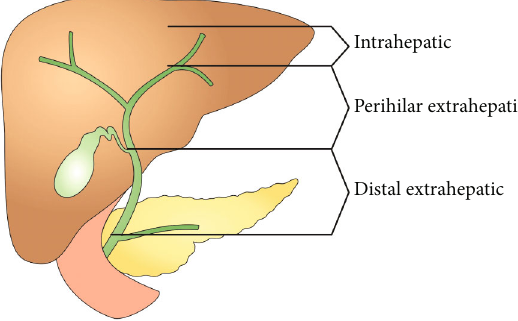
Figure 1: Classi fi cation of cholangiocarcinoma according to the anatomical